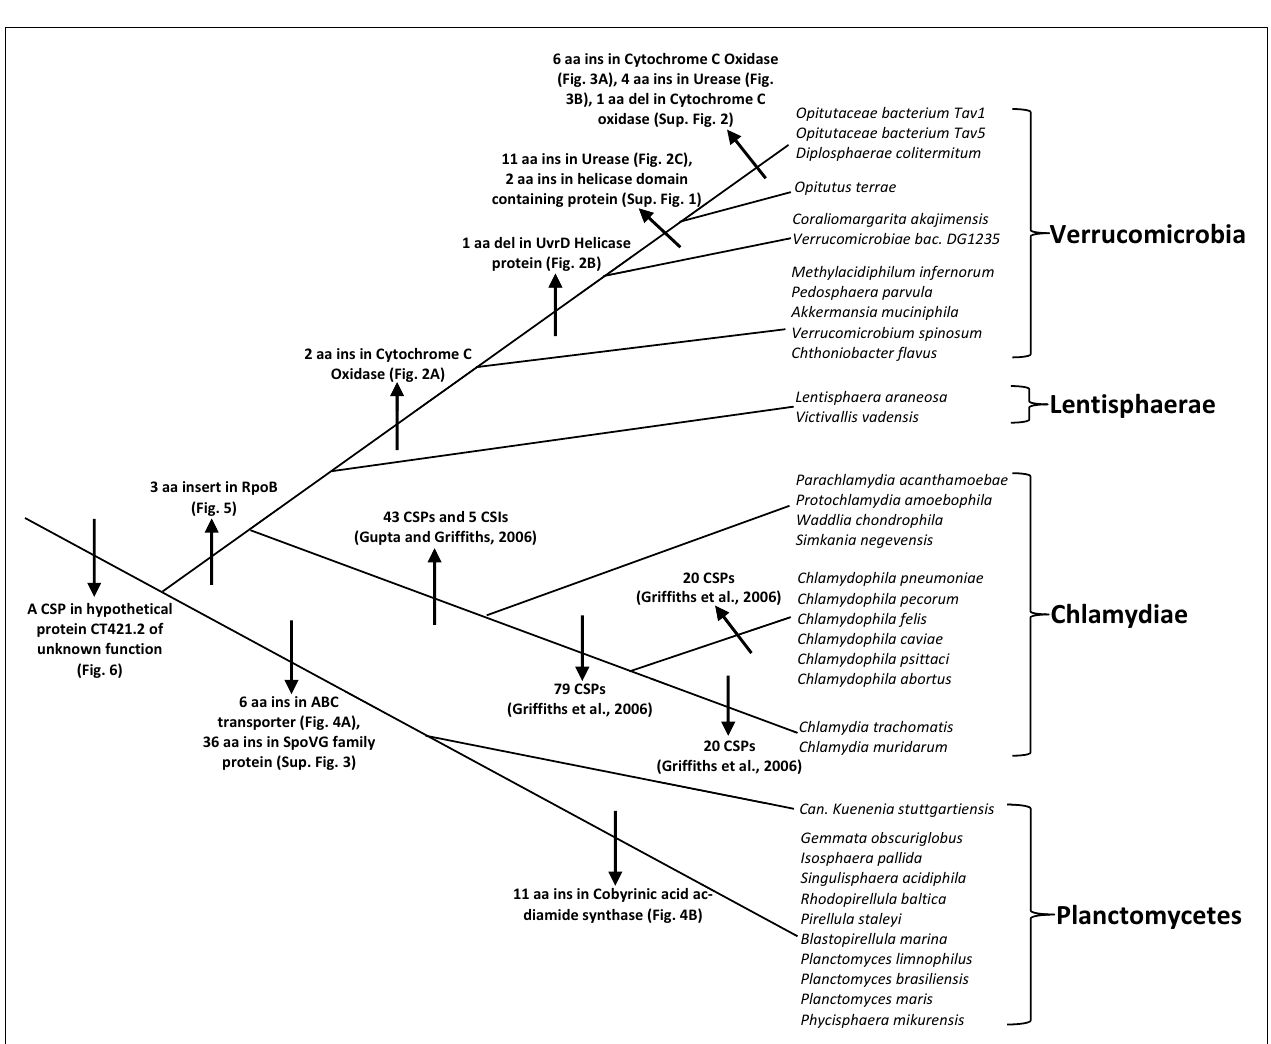
FIGURE 7 |A summary diagram depicting the different CSIs and CSPs that have been identified for the PVC clade of bacteria and the predicted evolutionary stages where the genetic changes leading for these